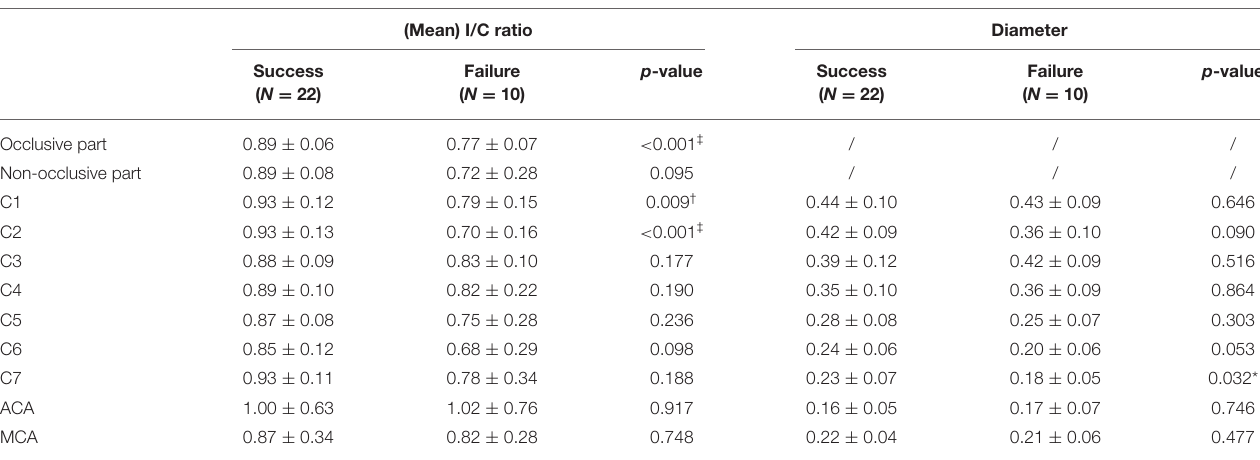
TABLE 3 | The I/C ratio and diameter of the occluded internal carotid